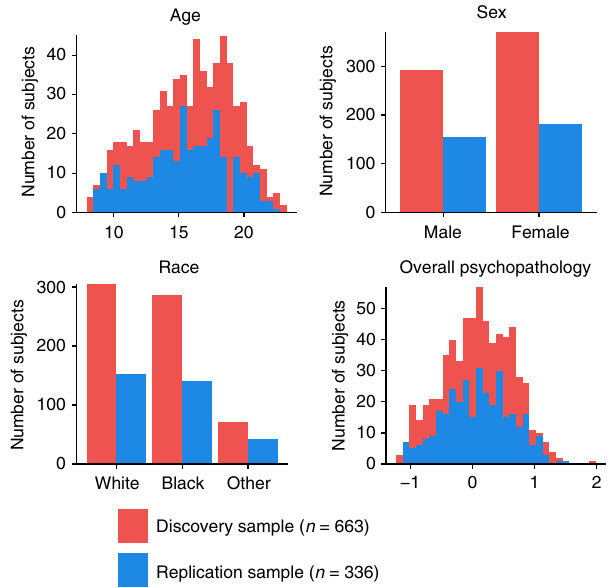
Fig. 1 Participants demographics. The discovery and replication samples had similar demographic composition, including similar distributions of